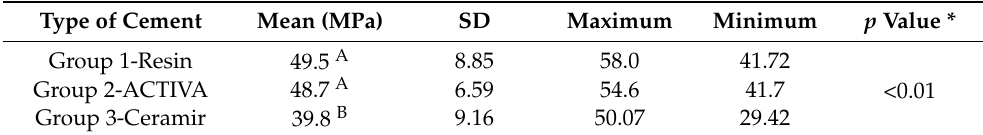
Table 1. Means and standard deviations (SD) for failure loads (MPa) among study groups.